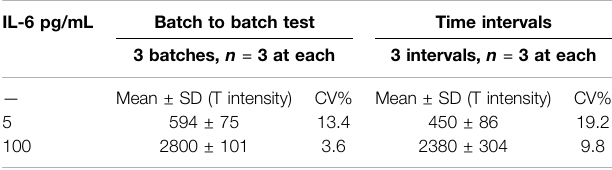
TABLE 1| Reproducibilitytest. LFAinthree differenttime intervals(1 day,1 week, and 1 month) and batch to batch